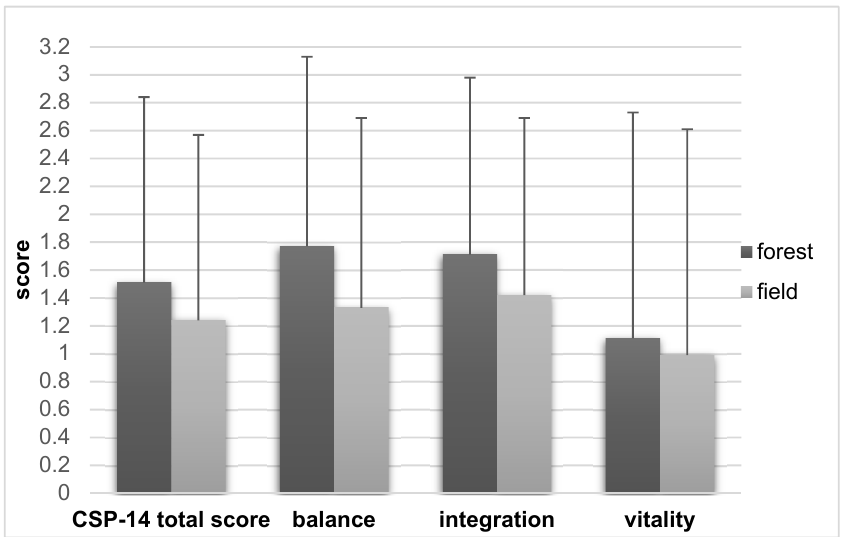
Figure 4. CSP-14 of the ITT autumn collective ( n = 15, mean values ± standard deviation), comparison of forest and field interventions.